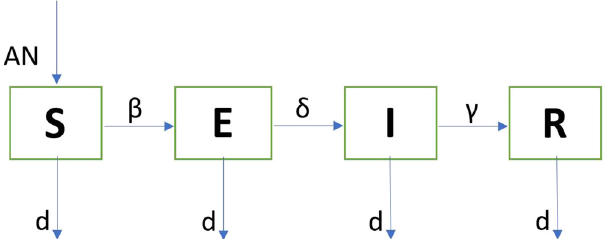
Figure 1: SEIR model for malaria